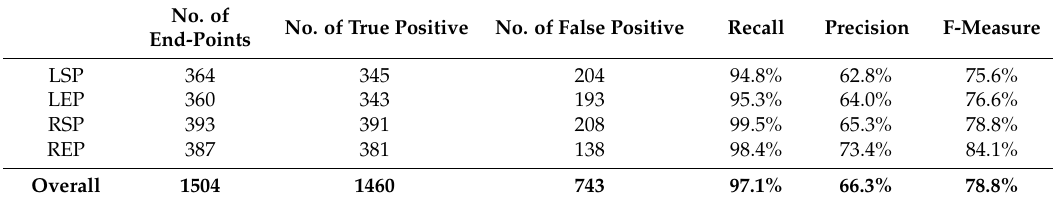
Table 7. Performance of the method [31] in daytime.